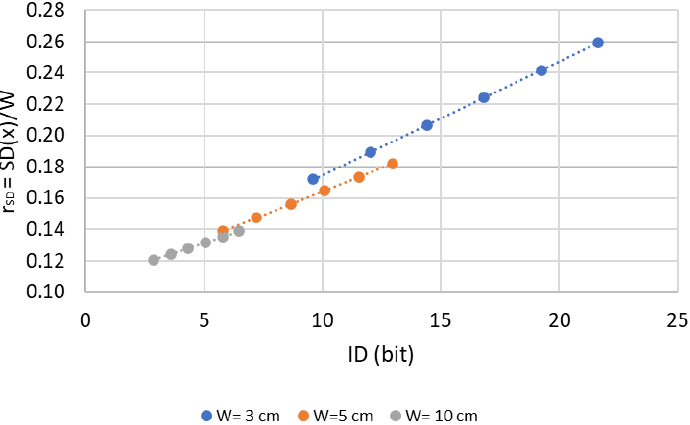
Figure 4. Accuracy of the endpoint position in a Tunnel Traveling Task: (r SD = SD(x) / W) vs. ID for different W values.